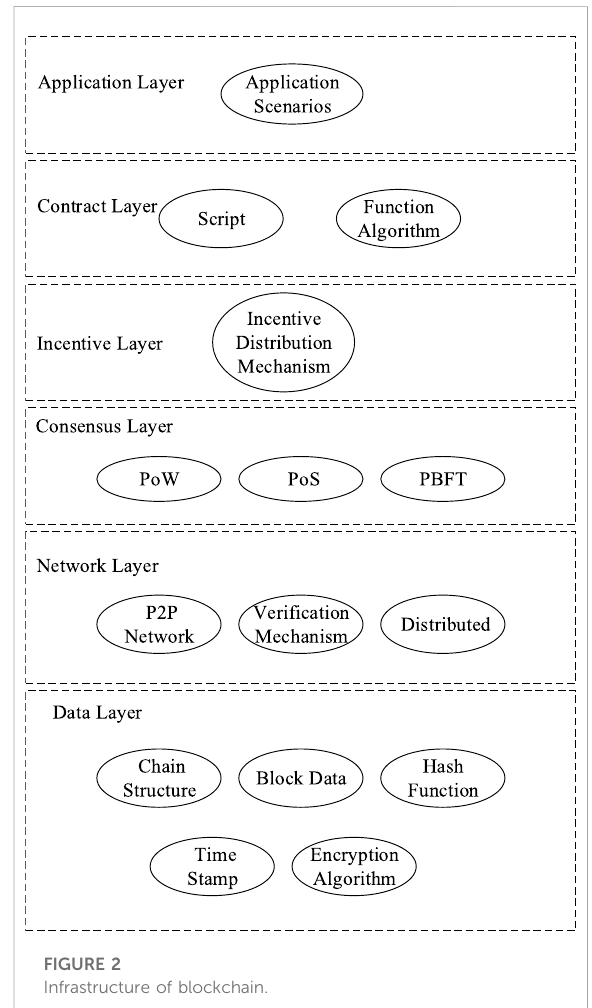
FIGURE 2 Infrastructure of